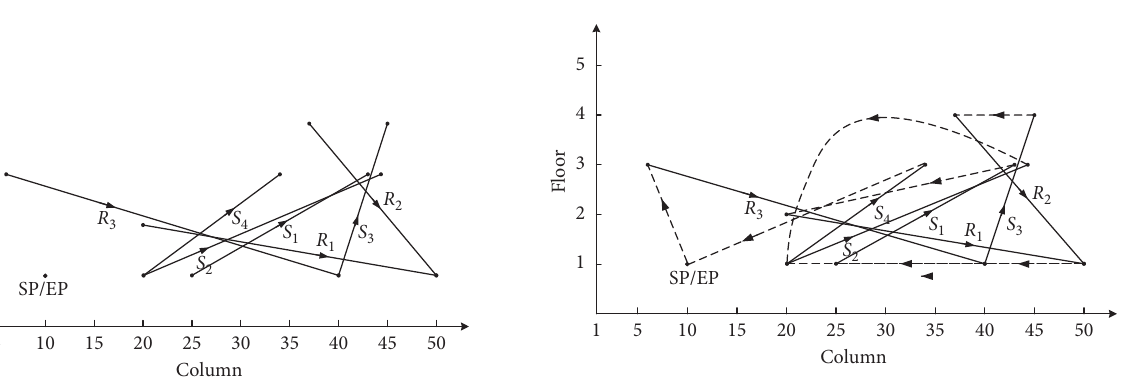
Figure 8: An example of four storage requests and three retrieval requests: the horizontal axis and the vertical axis represent the column and floor, where the stacker access point is located,